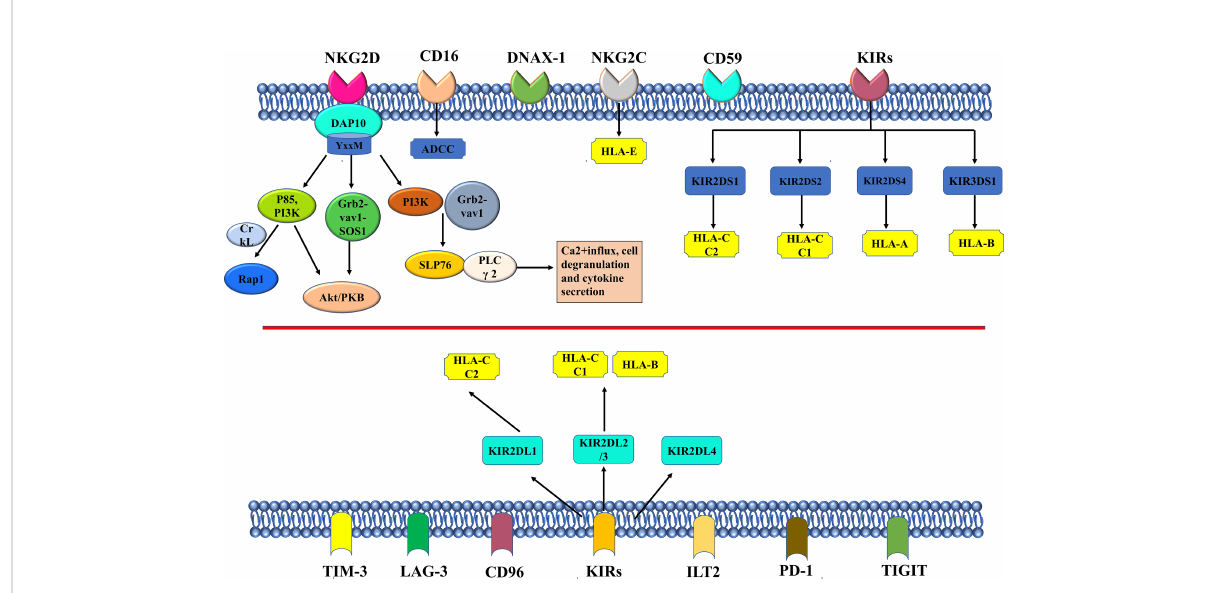
FIGURE 2 The mechanism of NKG2D, other important activating receptors, and the inhibitory receptors in NK